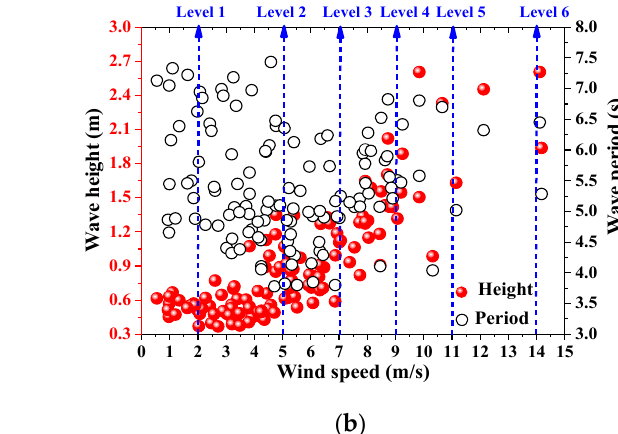
Figure 7. Relationship between wind speed, wave height and wave period in the Yellow Sea in January and August 2017. ( a ) January, ( b ) August.